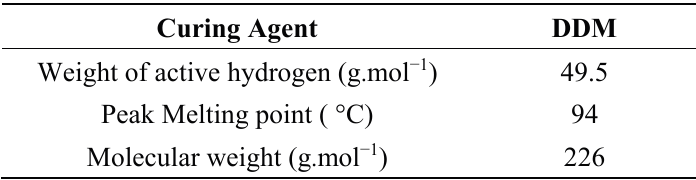
Table 1. Properties of 4, 4’ diamine-diphenylmetane